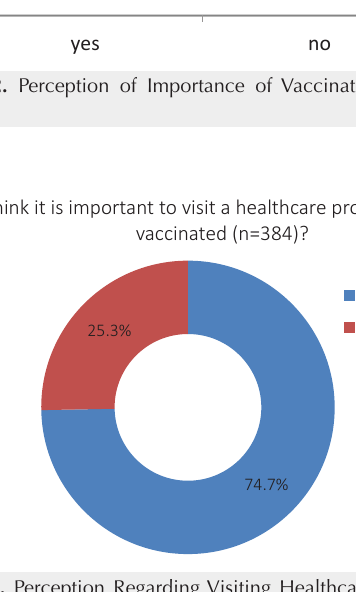
Figure 3. Perception Regarding Visiting Healthcare Providers When Already Vaccinated.